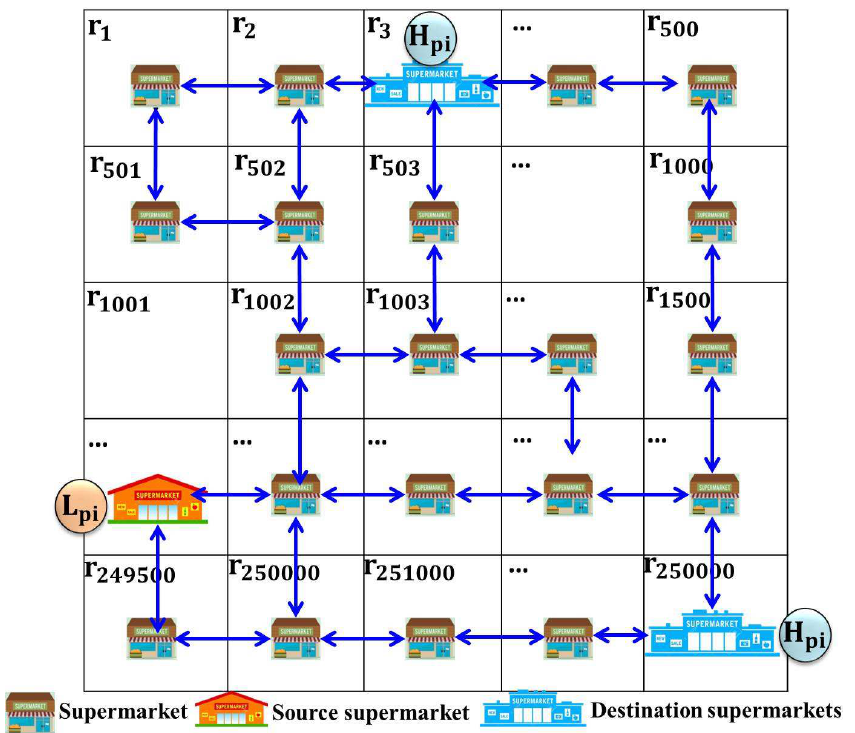
Figure 4. Simulation environment for